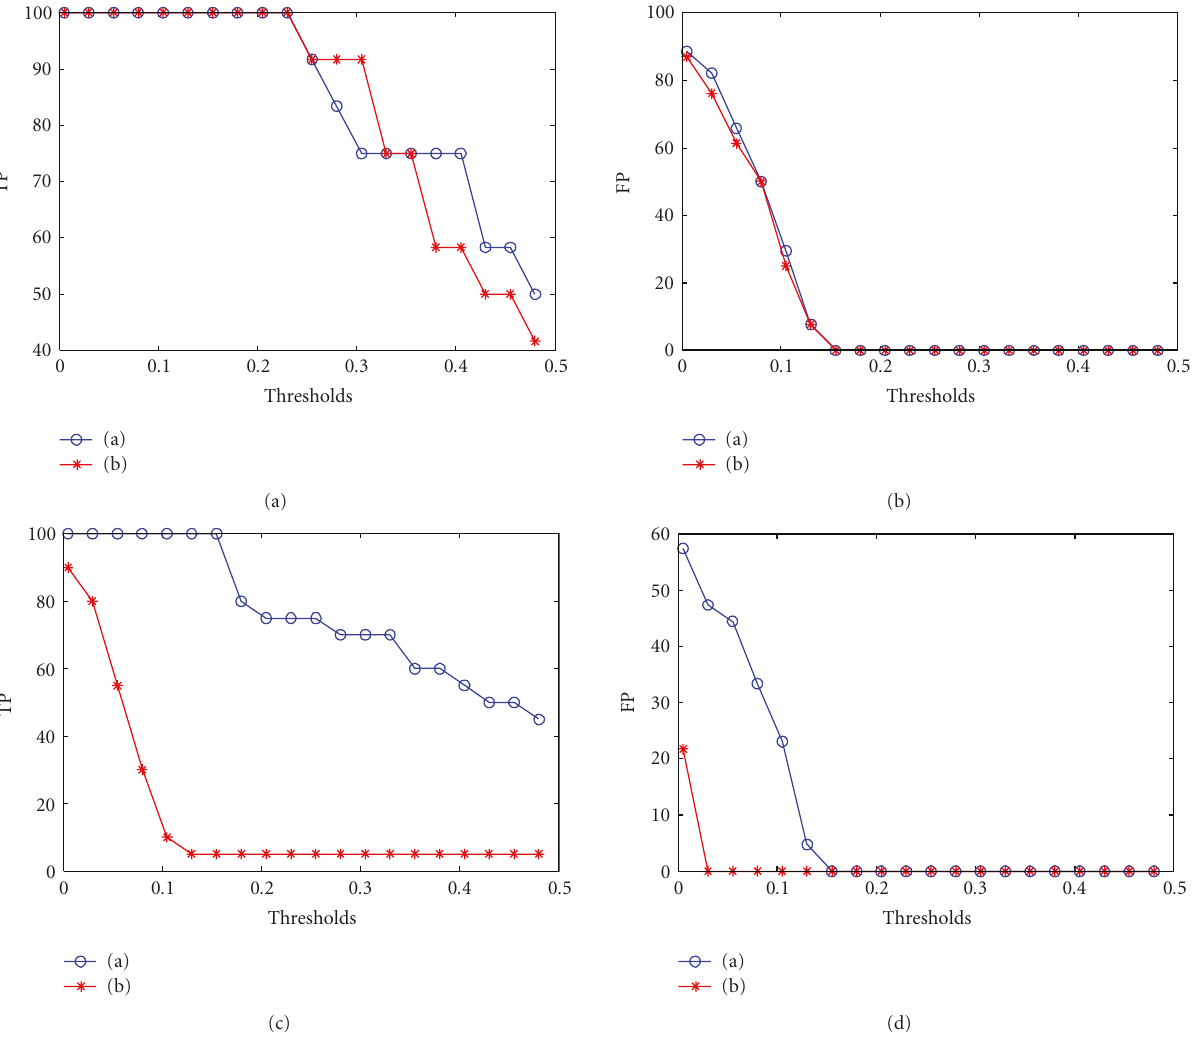
Figure 20: Test results of TP and FP against di ff erent thresholds for the two real music signals in Figures 7 and 14. Plot (a) corresponds to the proposed approach, and (b) to the RMS approach. The upper two plots correspond to the test results for the piano signal in Figure 7, while the below two plots correspond to the test results for the guitar signal in Figure 14. In this test, twenty di ff erent thresholds between 0.025 and 0.5 were